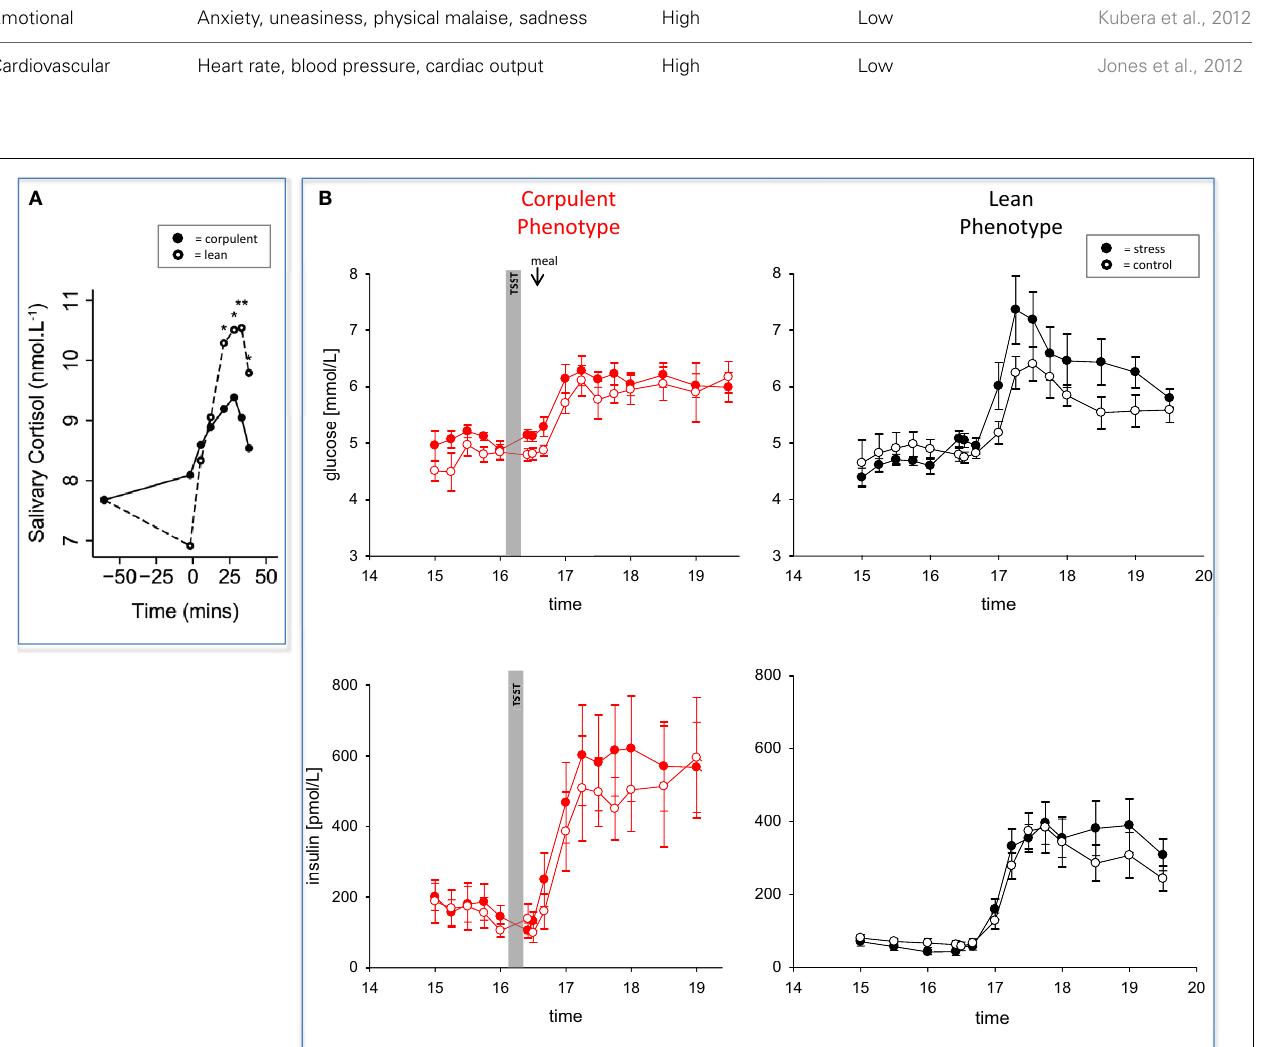
FIGURE 3 | The effect of mental stress on cortisol and CIS in lean and corpulent humans. (A) HPA-reactivity is low in corpulent subjects: lean subjects respond to a mental stressor in a high-reactive manner, while corpulent subjects respond to it in a low-reactive manner (Jones et al., 2012). (B) CIS is not detectable in corpulent subjects: glucose and insulin concentrations are measured during stress and non-stress intervention in corpulent and lean men. Values are means ± SEM; closed symbols, stress intervention and open symbols, non-stress intervention. Lean men: glucose concentrations are different from non-stress intervention (interaction time ×